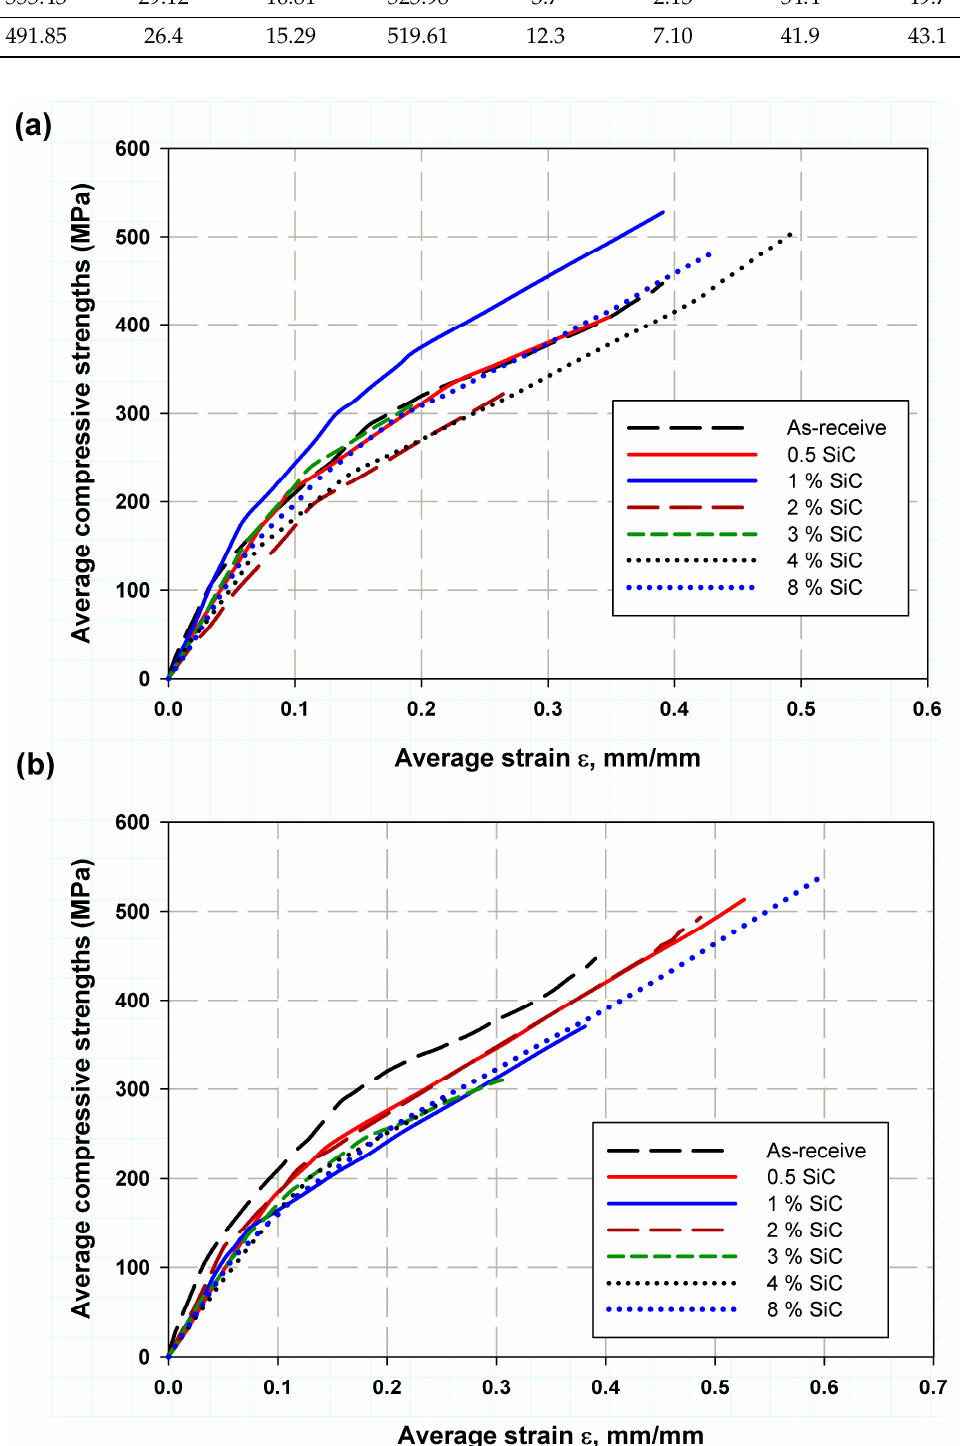
Figure 6. Average stress and strain relation for the Al-Si-Mg alloy filled with SiC in ( a ) graphite mold, ( b ) a steel mold.